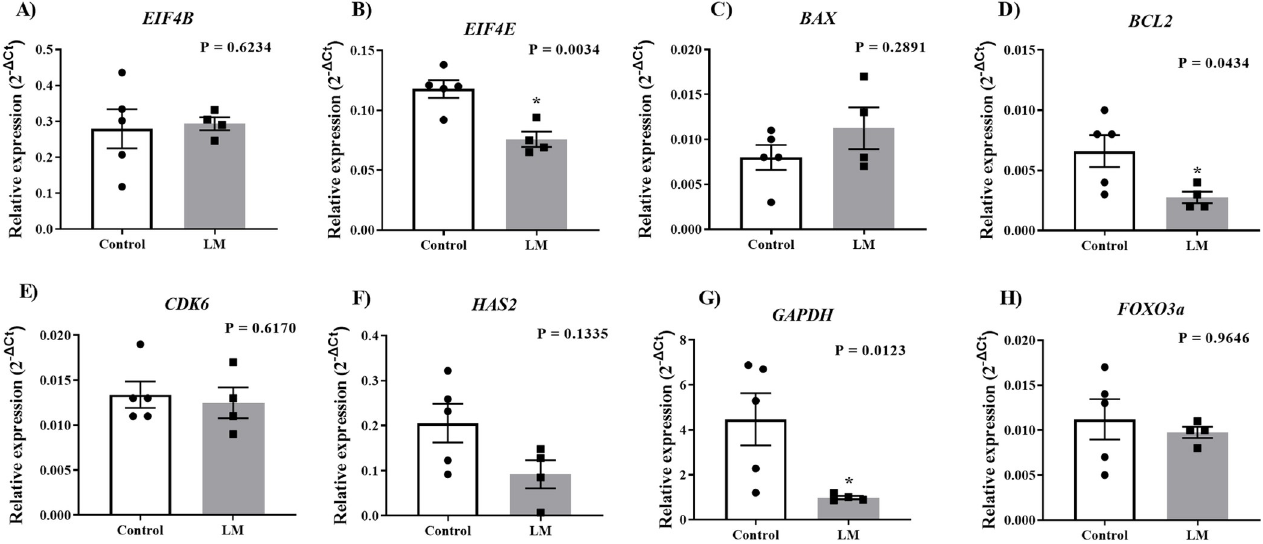
Fig 4. Target transcripts analysis in cumullus cells. Relative expression of A) EIF4B; B) EIF4E ; C) BAX; D) BCL2; E) CDK6; F) HAS2; G) GAPDH and; H) FOXO3a genes in cumulus cells from COCs matured for 22h in conventional or LM systems (5 biological replicate). Transcripts levels analysis were compared using Student’s t test and asterisk means statistical difference, considered when P < 0.05. Standard bars represents the SEM. https://doi.org/10.1371/journal.pone.0284809.g004 morphological classification of these blastocysts (early blastocyst, blastocyst, expanded blasto- cyst, and hatched blastocyst) appears to be homogeneous between the groups (Fig 6B), since the LM group, despite having more expanded blastocysts, also has a higher rate of initial blas- tocysts and a lower rate of hatched blastocysts. Additionally, the blastocysts did not present